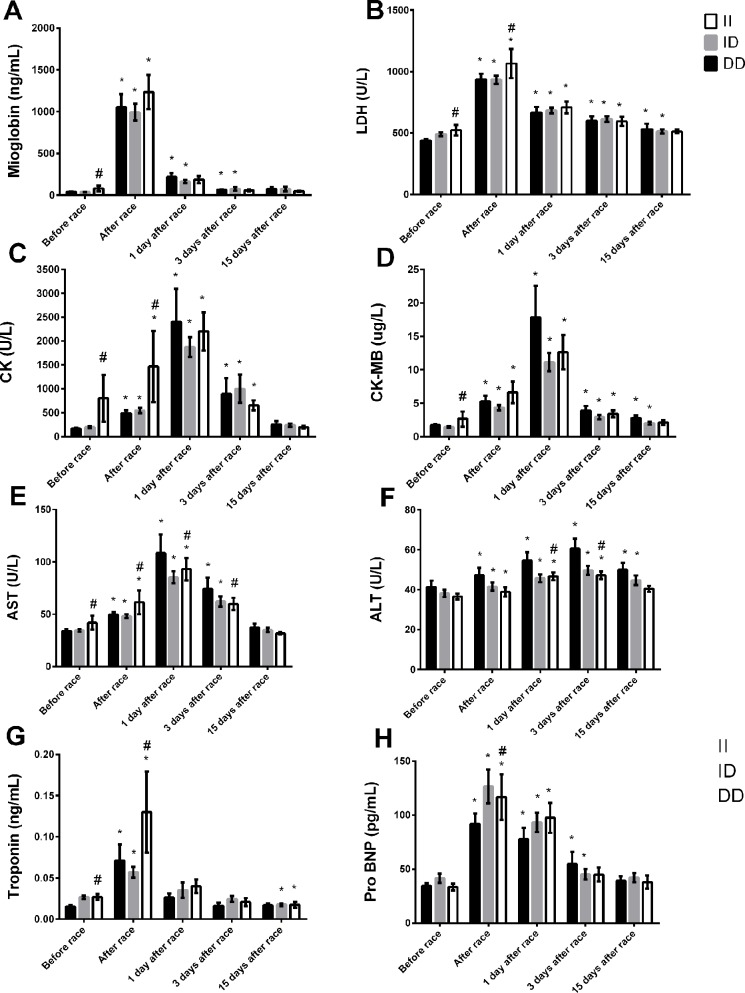
Effect of marathon on markers of muscle damage in DD, ID and II ACE genotypes. The markers of muscle damage evaluated were myoglobin (A); lactate dehydrogenase, LDH, (B); creatine kinase, CK (C); CK-MB (D); aspartate transaminase, AST (E); alanine transaminase, ALT (F); troponin (G); brain natriuretic peptide, Pro BNP (H). The values are presented as of mean ± SEM of 13–47 runners. *P < 0.05 vs before; #P < 0.05 II vs DD genotype.